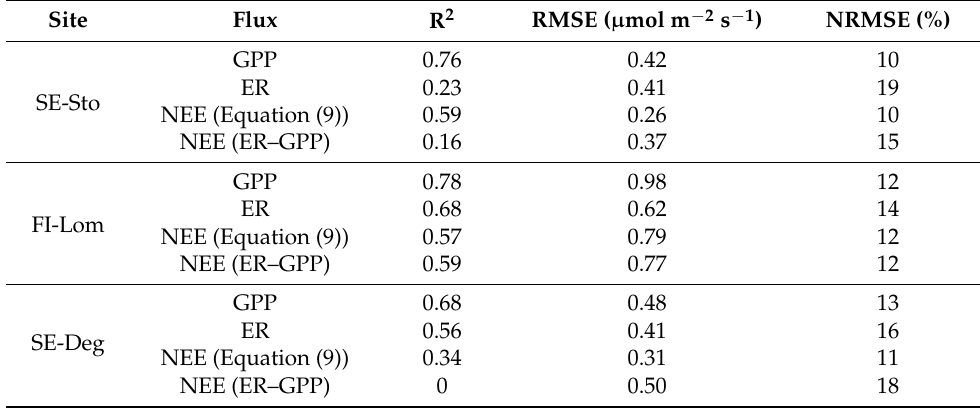
Table 2. Goodness-of-fit statistics for the predicted GPP, ER, and NEE, using the LOOCV parameter- ized models, for all available site years. NRMSE is RMSE normalized using the range (maximum– minimum) of the EC-derived flux.